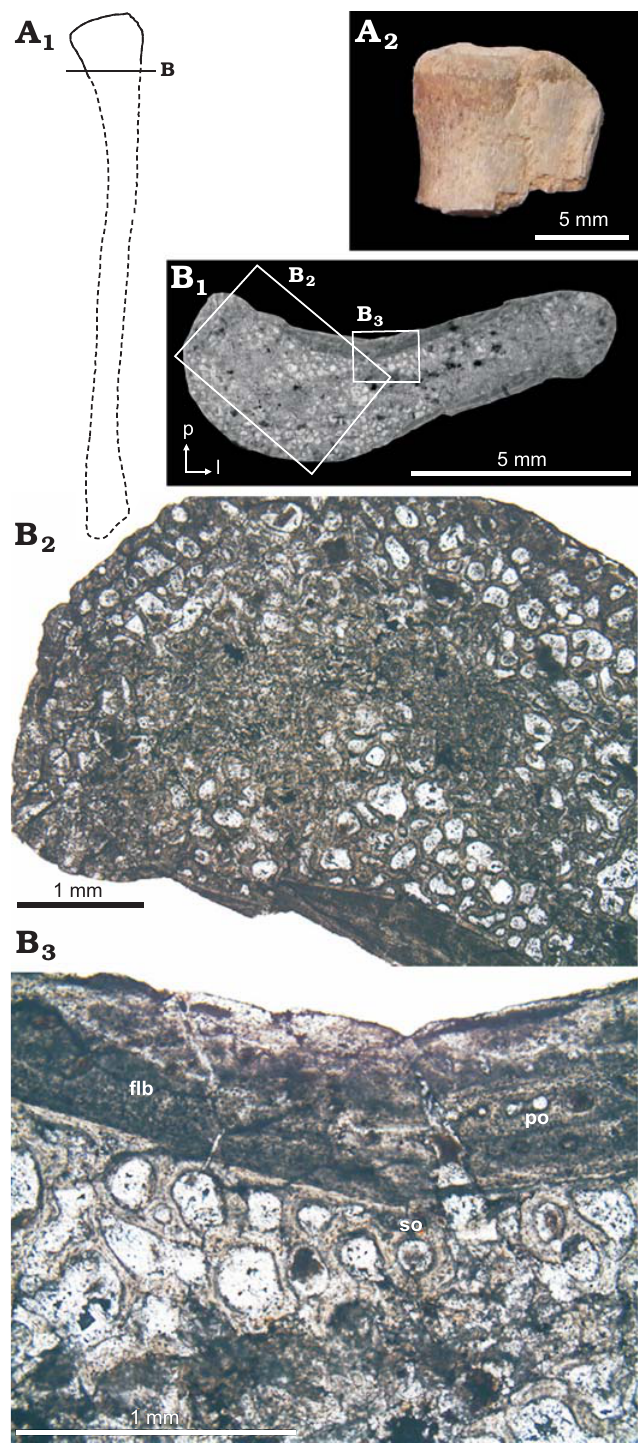
Fig. 6. Fibula microstructure of Proterochampsia indet. from the early Car nian Chañares Formation at the Río Gualo locality. A . PULR-V 117, in anterior view; photograph of proximal part (A 2 ), explanatory drawing (A 1 ); lines indicate the position of the cross-sections (redrawn from Romer 1972). B . PULR-V 117, cross-section in general view (B 1 ); details (B 2 , B 3 ), photomicrographs in plane-polarized light; note the fibrolamellar bone (fbl) with primary osteons (po) on the anteromedial surface; second- ary osteons (so) and resorption cavities in the mid- to inner cortical region. Abbreviations: a, anterior; l, lateral; p,